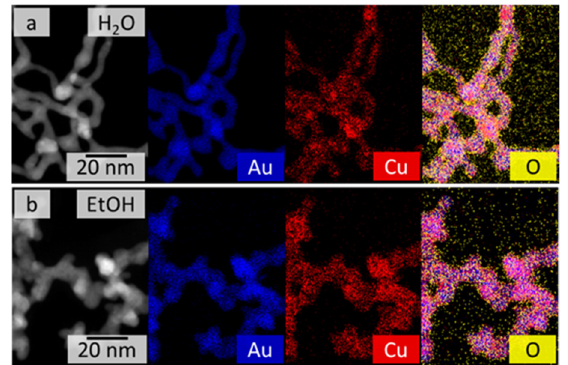
Figure 2. HAADF-STEM images (left) and EDX-based element distributions of the AuCu gel synthesized in water ( a ) and ethanol ( b ). Both gels demonstrate a quite homogeneous distribution of Au and Cu over the entire gel networks.